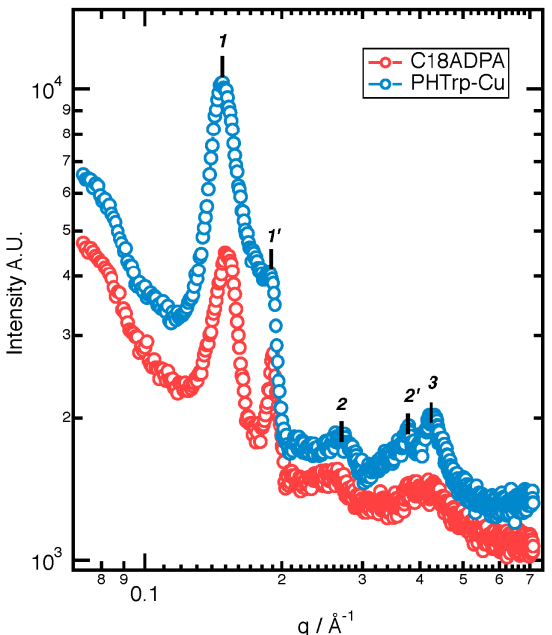
Figure 6. L-XRD data of the C18ADPA hydrogel and the PHTrp-Cu hydrogel.